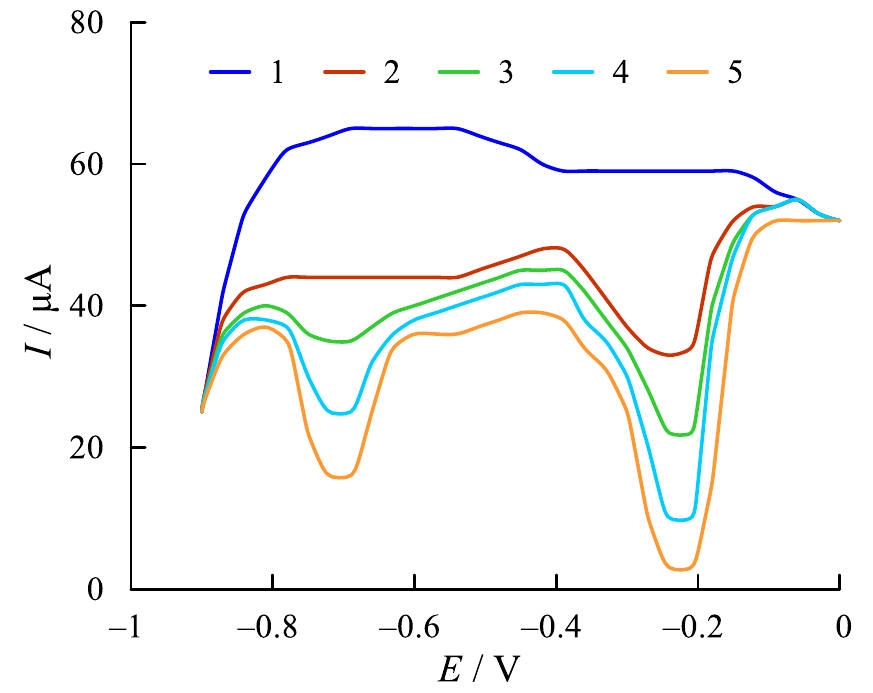
Figure 1. Capacitive current curves in phosphate buffer (2.5 × 10 –2 M, pH 7.3) on the glassy carbon electrode (GCE) without (1) and with cobalt phthalocyanine 2.5 × 10 −5 M (2), 5.0 × 10 –5 M (3), 7.5 × electrode (GCE) without (1) and with cobalt phthalocyanine 2.5 × 10 − 5 M (2), 5.0 × 10 − 5 M (3), 10 –5 M (4), and 1.0 × 10 –4 M (5). Scan rate: 50 mV s −1 . 7.5 × 10 − 5 M (4), and 1.0 × 10 − 4 M (5). Scan rate: 50 mV s − 1